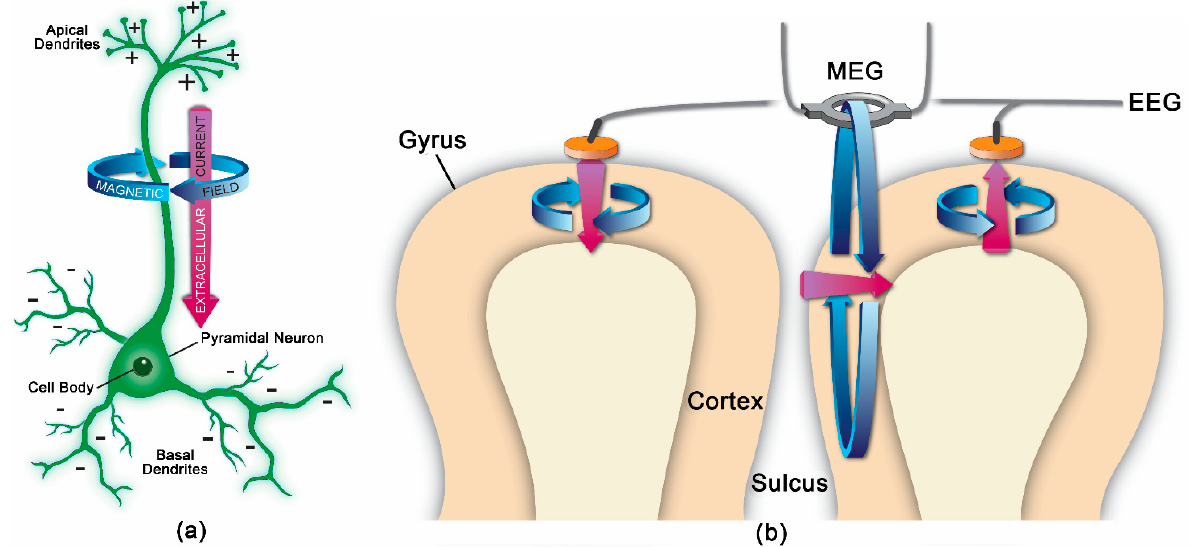
Figure 1. ( a ) Pyramidal neuron with positive extracellular charge around the apical dendrites and negative extracellular charge around the somatic dendrites, as in the case of a net excitatory post-synaptic potential at the somatic dendrites and/or a net inhibitory post-synaptic potential at the apical dendrites. Purple arrow represents the extracellular electric current, and blue arrows represent the magnetic field associated with the extracellular current; ( b ) Cortical gyri and sulcus with pink arrows representing electric dipoles from synchronized neuronal activity and blue arrows showing the magnetic fields associated with these electric dipoles. The MEG magnetometer only detects magnetic fields from dipoles oriented tangential to the cortical surface, whereas the EEG electrodes can detect radial and tangential electric dipoles. MEG = magnetoencephalography; EEG = electroencephalography.